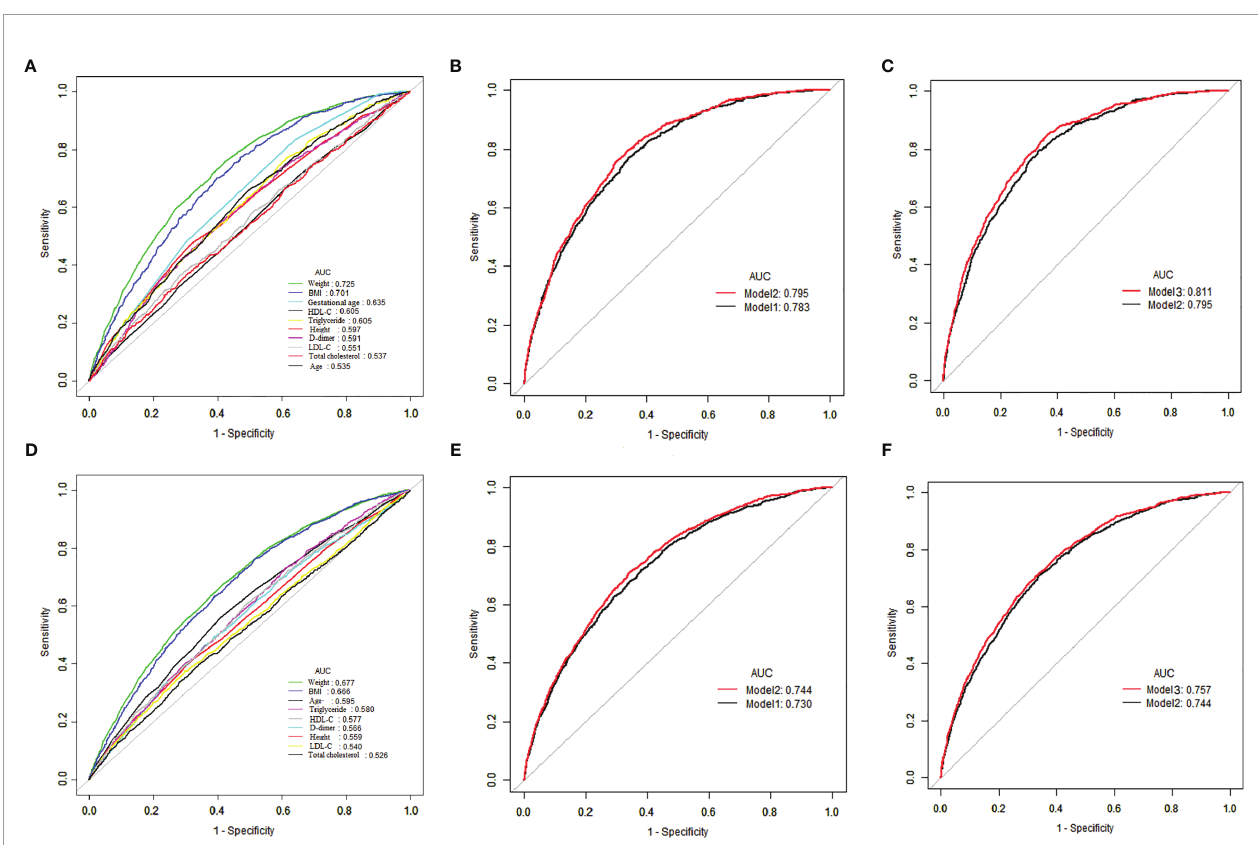
FIGURE 1 | ROC curves to compare the effects of different variables in predicting macrosomia and LGA infants in late pregnancy. Model 1, conventional model, namely, maternal age, BMI, gravidity, parity, gestational age, systolic and diastolic BP at hospital admission and fetal sex; Model 2, model 1 plus D-dimer; Model 3, model 2 plus blood lipids. (A) The prediction of macrosomia by individual variables. (B, C) Predictive ability of different models of macrosomia. (D) The prediction of LGA by individual variables. (E, F) Predictive ability of different models of LGA.